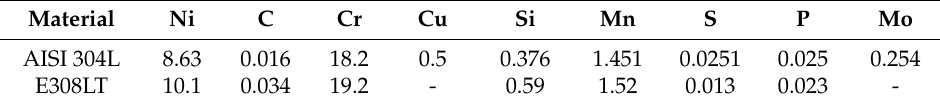
Table 1. Chemical compositions for AISI 304L and E308LT.